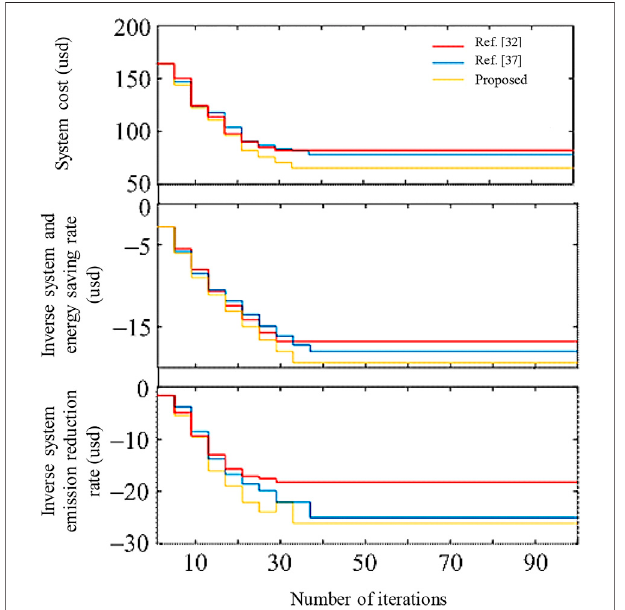
FIGURE 14 | Comparison of the proposed and existing algorithms vs. number of iterations.